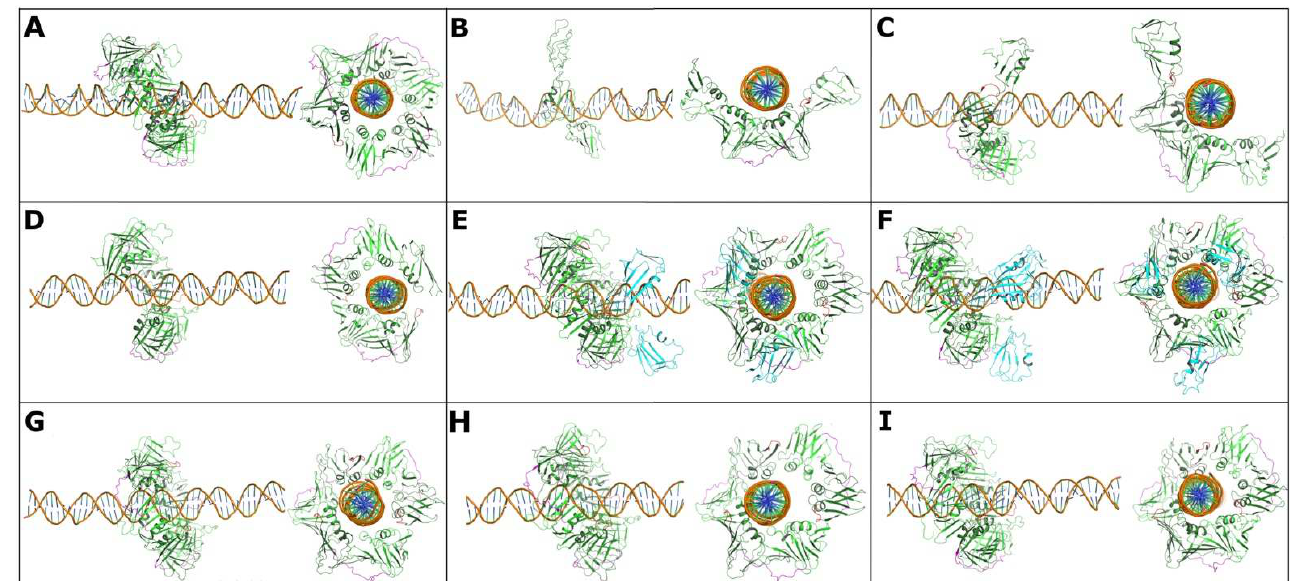
Figure 6. Representative conformations of different combinations of PCNA trimers. ( A ) PCNA native homotrimer showing a balanced structure where the DNA is located at the center of the homotrimer. ( B ) PCNA_V3 homodimer interacting with DNA. ( C ) Interaction of the PNCA_V3 homodimer with the PCNA native monomer and ( D ) the PCNA_V3 monomer with the PCNA native homodimer. ( E ) Interaction of PCNA native trimer (green) with PCNA_V3 homodimer (cyan), and ( F ) PCNA native homotrimer (green) with PCNA_V3 homotrimer (cyan). ( G ) PCNA_V4 homotrimer, also showing a relatively stable complex with DNA. ( H ) Interaction of the PCNA_V4 homodimer with the PCNA native monomer. ( I ) Interaction of the PCNA_V4 monomer with the PCNA native homodimer.